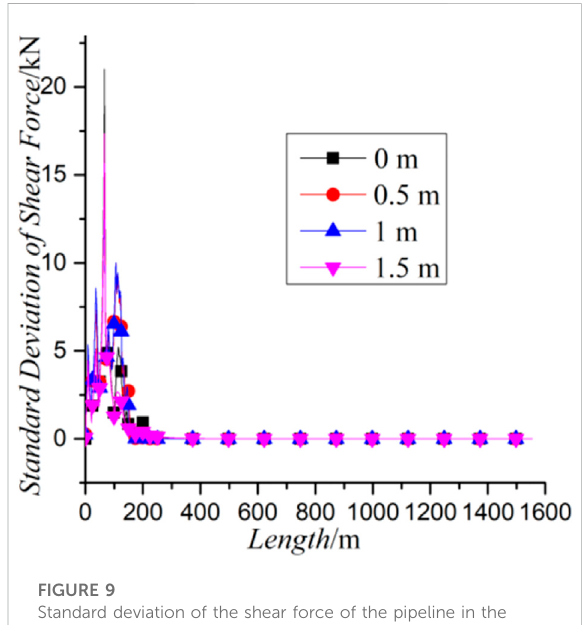
FIGURE 9 Standard deviation of the shear force of the pipeline in the length direction with different burial depths.